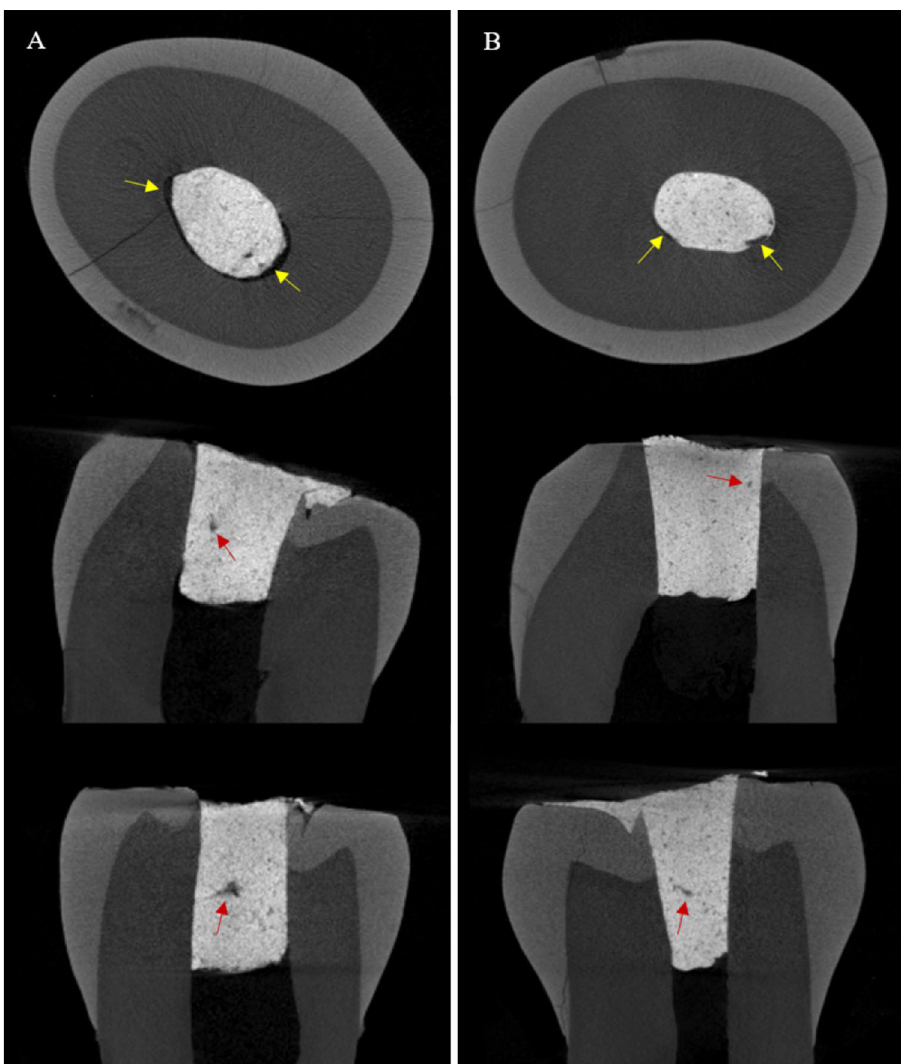
Figure 1. Representative micro-CT images (from top to bottom; axial, coronal, and sagittal views) of the two spacer groups: ( A ) cotton pellet, and ( B ) PTFE; showing the presence of gaps (yellow arrows) between the Cavit restoration and access cavity walls and voids (red arrows) within the Cavit restoration. The brightness of the original images was slightly adjusted to enhance